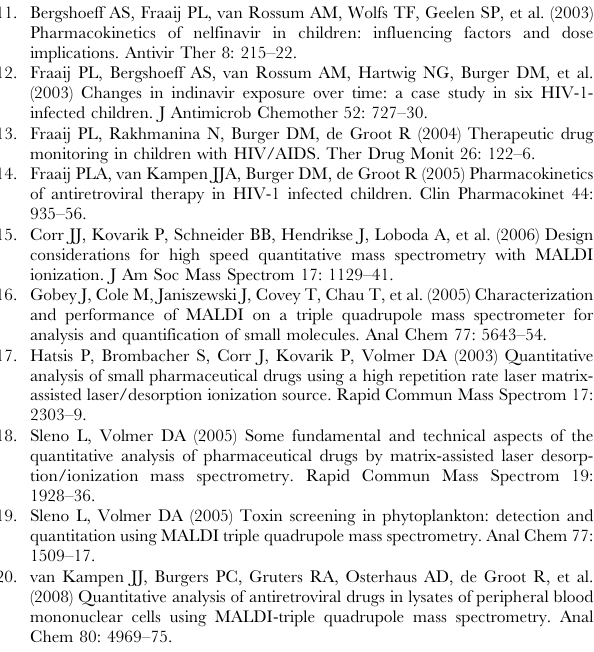
Table S2 Lopinavir and ritonavir concentrations in plasma in an HIV-1 infected child. The first column shows the time points in hours at which blood samples were collected from one HIV-1 infected child after observed intake of Kaletra. The second column shows the components of Kaletra, i.e. lopinavir and ritonavir. The third column shows the concentration of the compounds in m M determined by HPLC-UV. The fourth and fifth columns show the